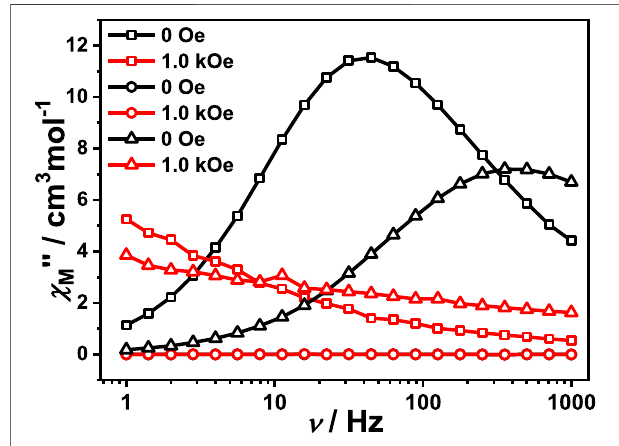
FIGURE 4 | Both 0 Oe and 1.0 kOe fi eld measurement performed on polycrystalline sample of complex 1 ( □ ), 1 a ( ○ ) and 1-back ( Δ ),